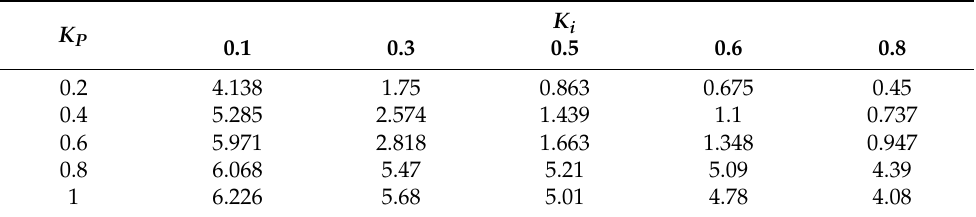
α 1 = 0.2 and α 2 =